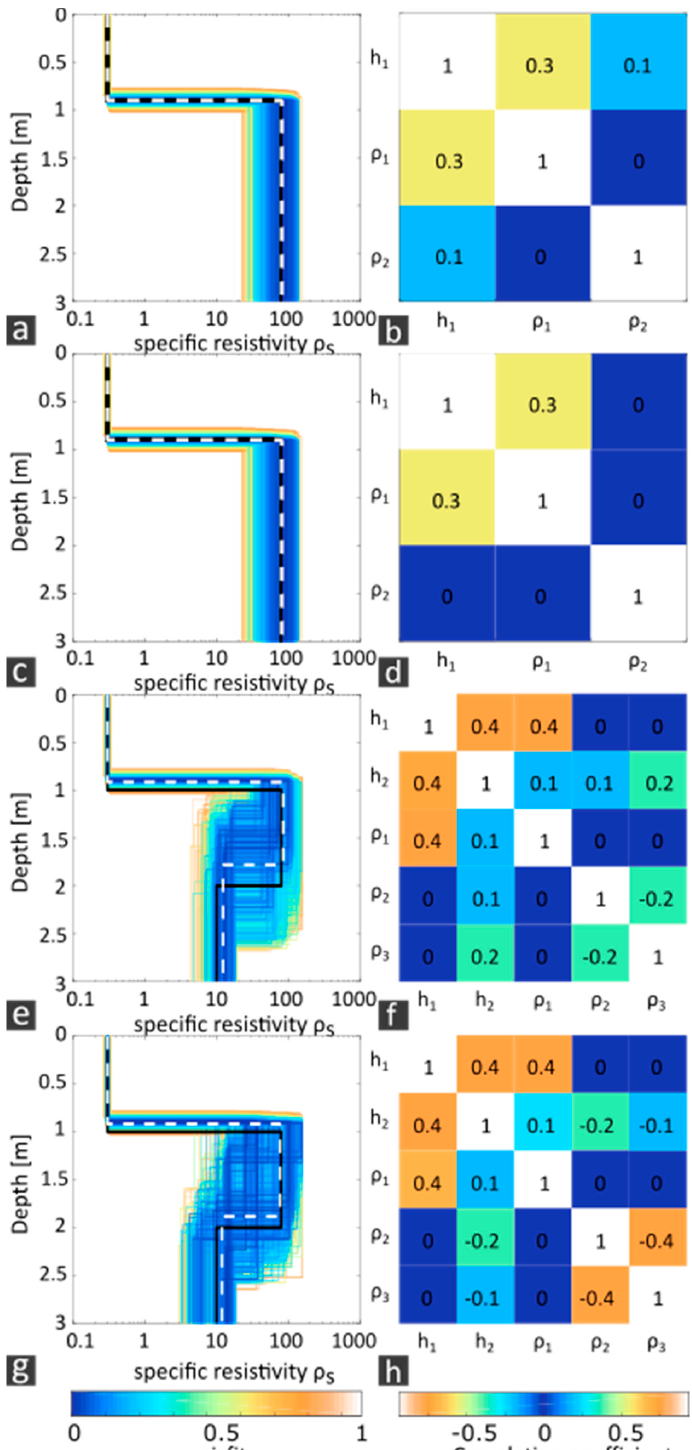
Figure 13. Left column: Model results from the stochastic inversion, color-coded by their misfit values and normalized to the relative misfit of 14%. The black line represents the true model, and the white dashed line represents the expected model. Right column: normalized correlation matrix of the subsurface parameters. ( a , b ) Case 2L and setup F, ( c , d ) case 2L and setup S, ( e , f ) case 3L and setup F as well as ( g , h ) case 3L and setup S are distinguished.